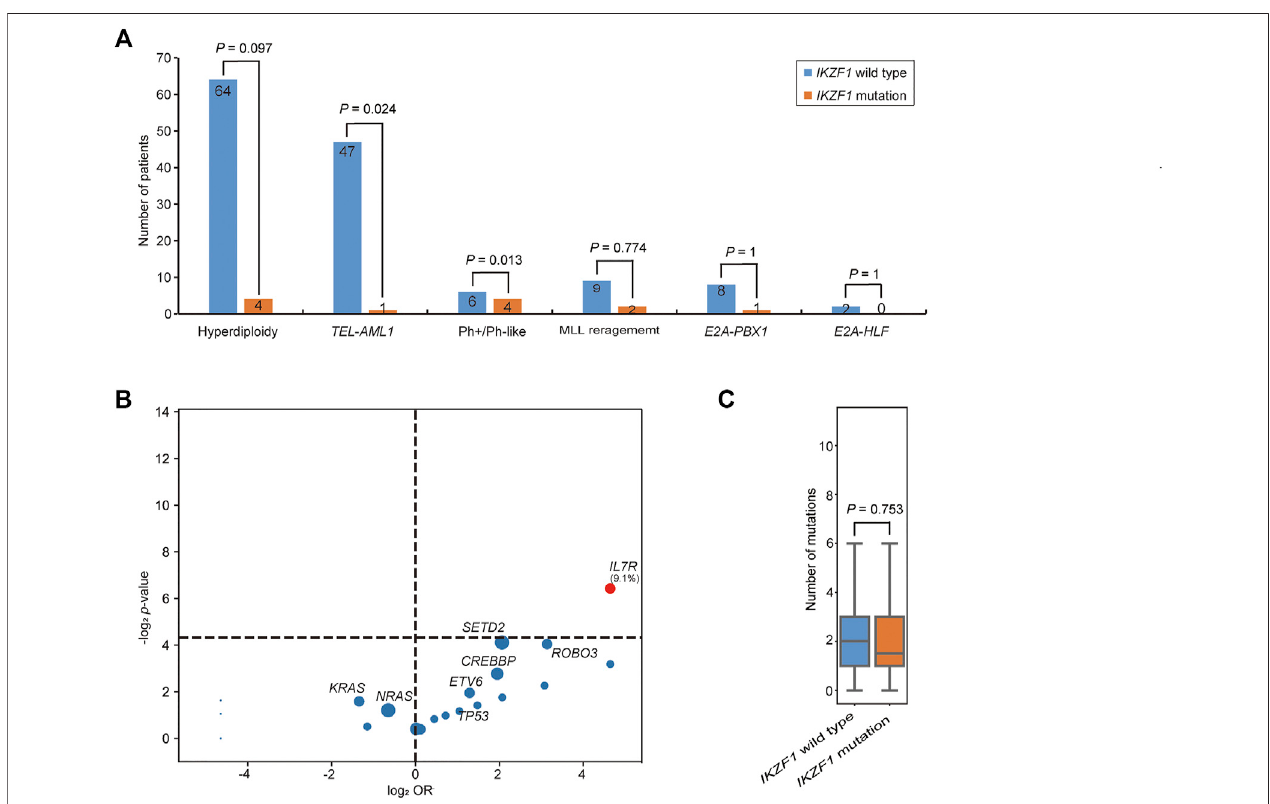
FIGURE 3 | Comparison of genetic characteristics between IKZF1 mutant and wild-type patients. (A) Bar chart shows the associations between IKZF1 mutations and different cytogenetics or genetic aberrations. (B) Volcano plot shows the distribution of genetic characteristics according to IKZF1 mutant and wild-type patients. The x axis indicates the magnitude of association (log 2 odds ratio), and the y axis represents the − log 2 p value. Each circle shows a mutated gene and the size of each circlerepresentsthefrequencyofthemutatedgene. (C) Boxplotshowsthecomparisonofthenumberofmutationsbetween IKZF1 mutantandwild-typepatients.